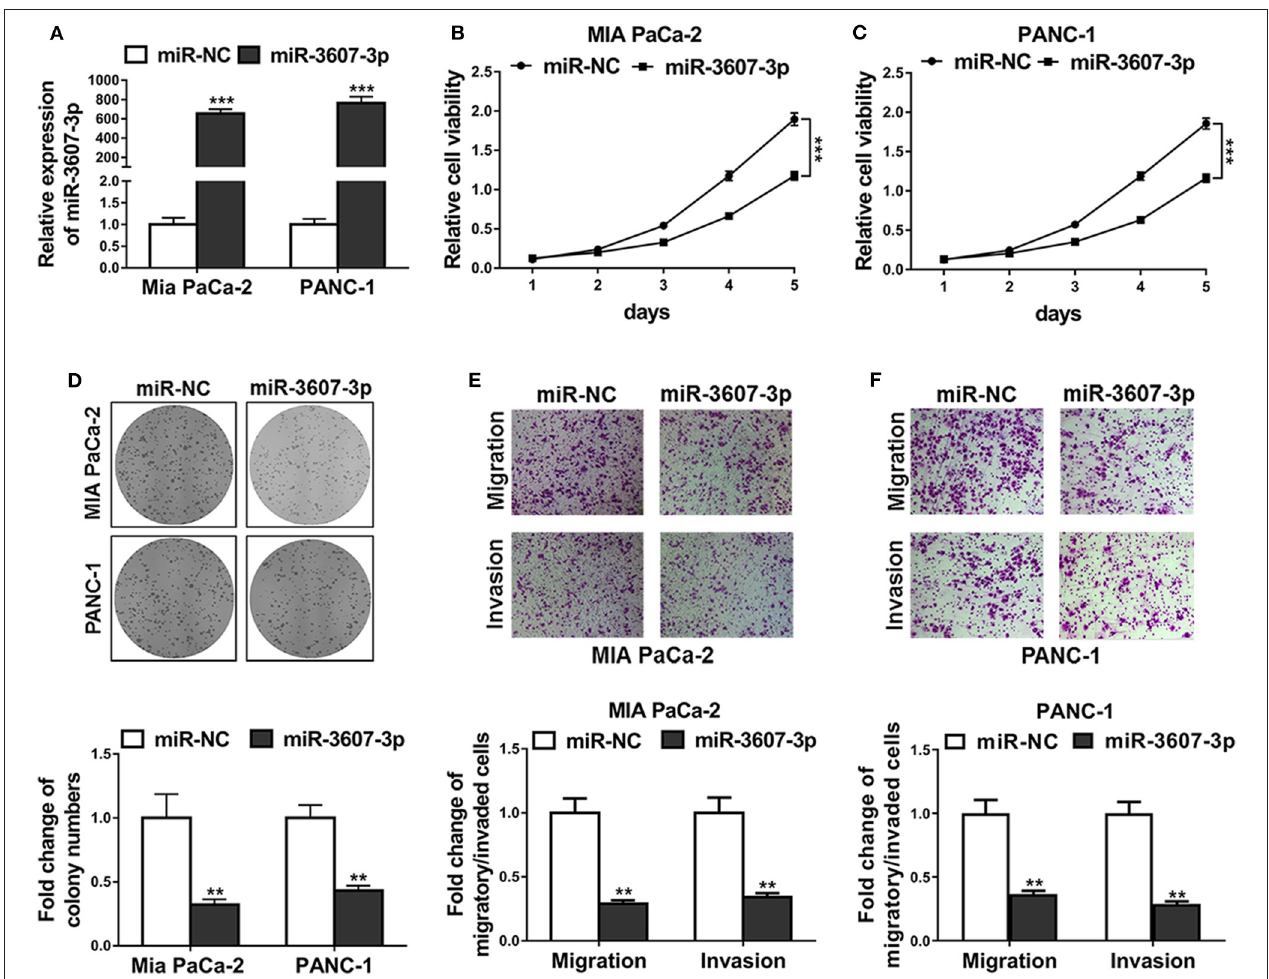
FIGURE 5 | MiR-3607-3p suppressed proliferation, migration and invasion of pancreatic cancer cells. (A) Mia PaCa-2 and PANC-1 cells were transfected with miR-3607-3p mimics (miR-3607-3p) or mimics negative control (miR-NC), miR-3607-3p expression levels were quantified by qRT-PCR analysis. (B,C) CCK-8 assay showed cell viability of Mia PaCa-2 and PANC-1 cells transfected with miR-3607-3p mimics (miR-3607-3p) or mimics negative control (miR-NC). (D) Colony formation assay showed cell proliferation of Mia PaCa-2 and PANC-1 cells transfected with miR-3607-3p mimics (miR-3607-3p) or mimics negative control (miR-NC). (E,F) Transwell assays showed cell migratory and invasive ability of Mia PaCa-2 and PANC-1 cells transfected with miR-3607-3p mimics (miR-3607-3p) or mimics negative control (miR-NC). The data represent the mean ± SD from three independent experiments. ** P < 0.01; *** P < 0.001. Two-way ANOVA for b and c, Student’s t -test for